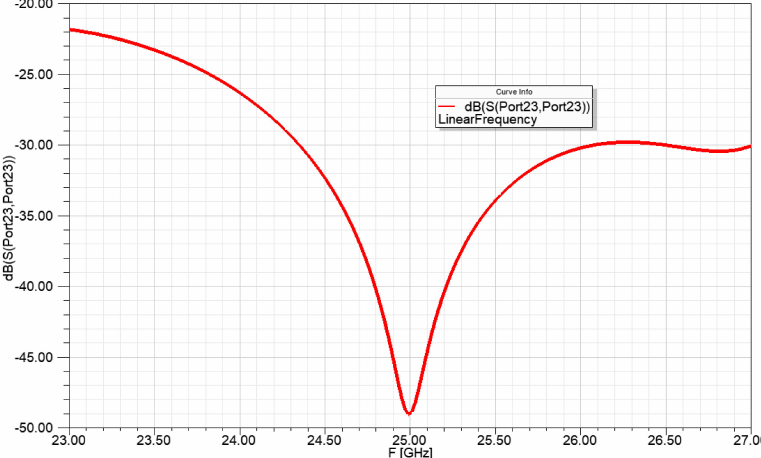
Figure 18. Input reflection of the power division network for 1 to 2:10:10:2 power ratio, with ideal transmission